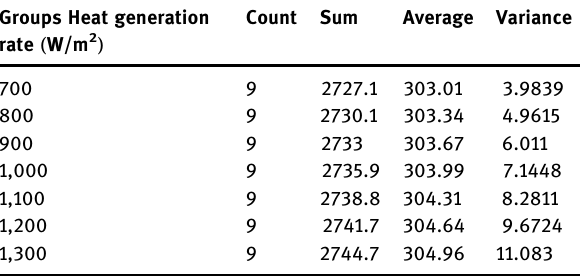
Table 7: Data summary of the results of the heat generation rate on variations in the shape with temperature